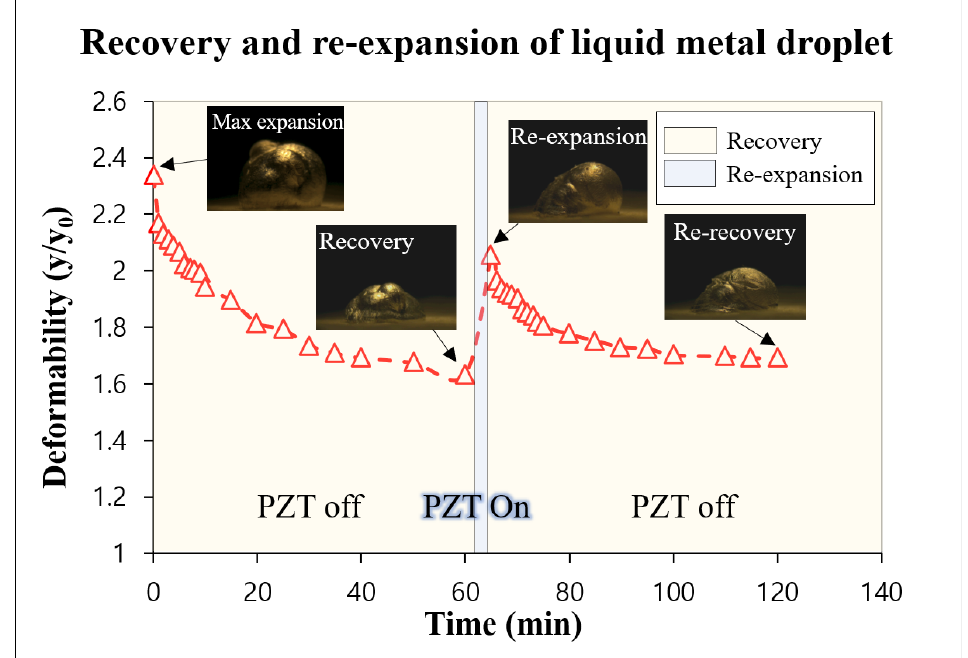
Figure 6. The deformation of the liquid metal droplet in the y -axis direction with/without an acoustic wave after maximum expansion.